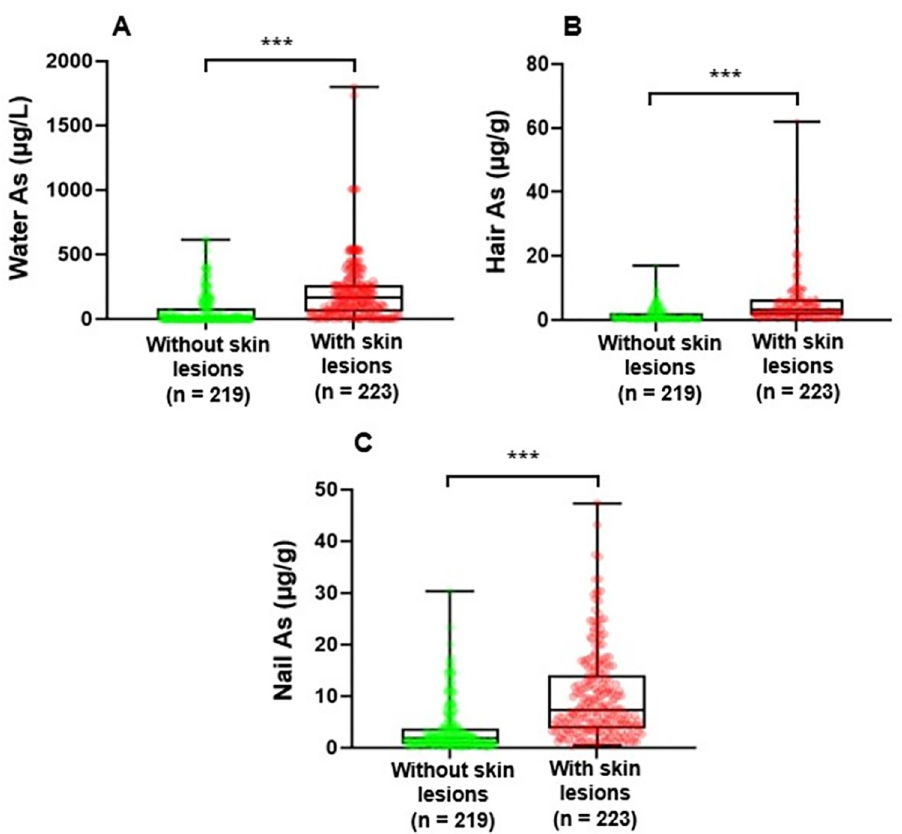
Fig 2. Comparisons of arsenic exposure levels between the groups of participants with and without skin lesions using box and whisker plots. Comparisons of water (A), hair (B), and nail (C) arsenic levels between the groups of participants with and without skin lesions. The center line indicates the median value, the box contains the 25th to 75th percentiles of the dataset. The whiskers mark the minimum and maximum values. The dots show the individual data points. Mean rank differences were assessed by using the Mann-Whitney U test between each skin lesions group. ��� p < 0.001.